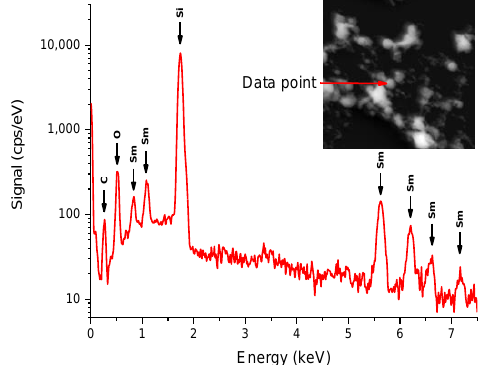
Figure 5. Energy-dispersive X-ray spectroscopy (EDS) spectrum of synthesized NPs. Strong signals from samarium and oxygen are related to synthesized NPs. The silicon peak is related to the Si substrate, while the carbon signal is related to organic contamination of the vacuum chamber.